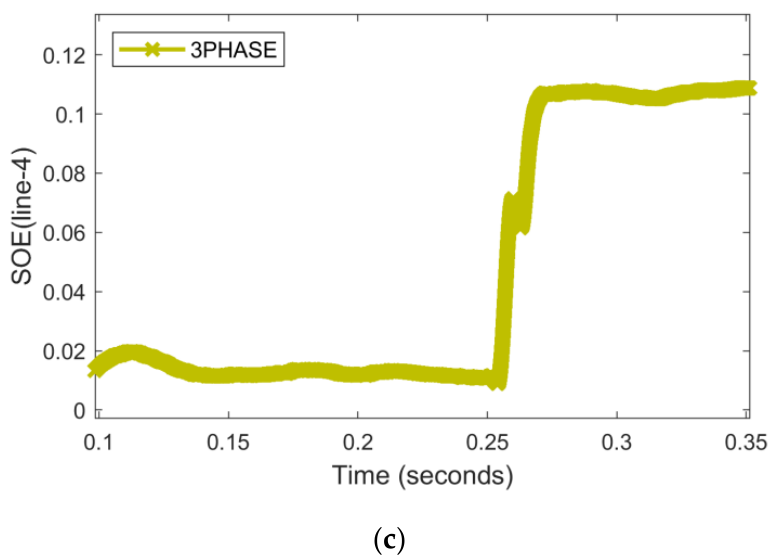
Figure 7. An HI double line-to-ground fault with Z L = 50 Ω hits phase A and C in TU mode. ( a ) Current signals ( b ) PFD ( c ) RNN-assisted SOE.